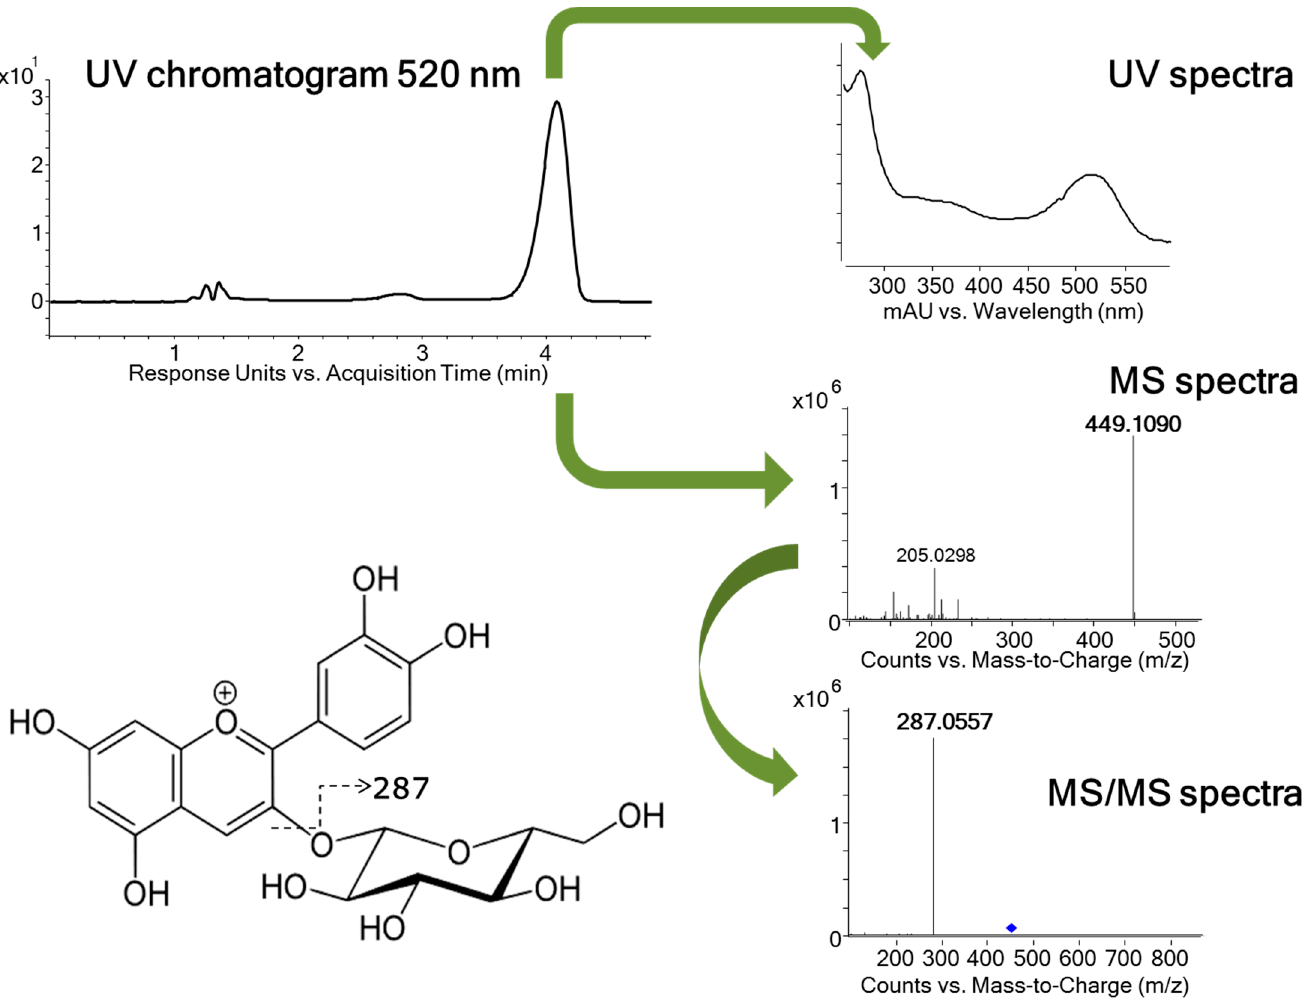
Figure 1. Fragmentation pattern of cyanidin-3- O -glucoside. MS/MS spectra has been obtained by auto MS/MS fragmentation.